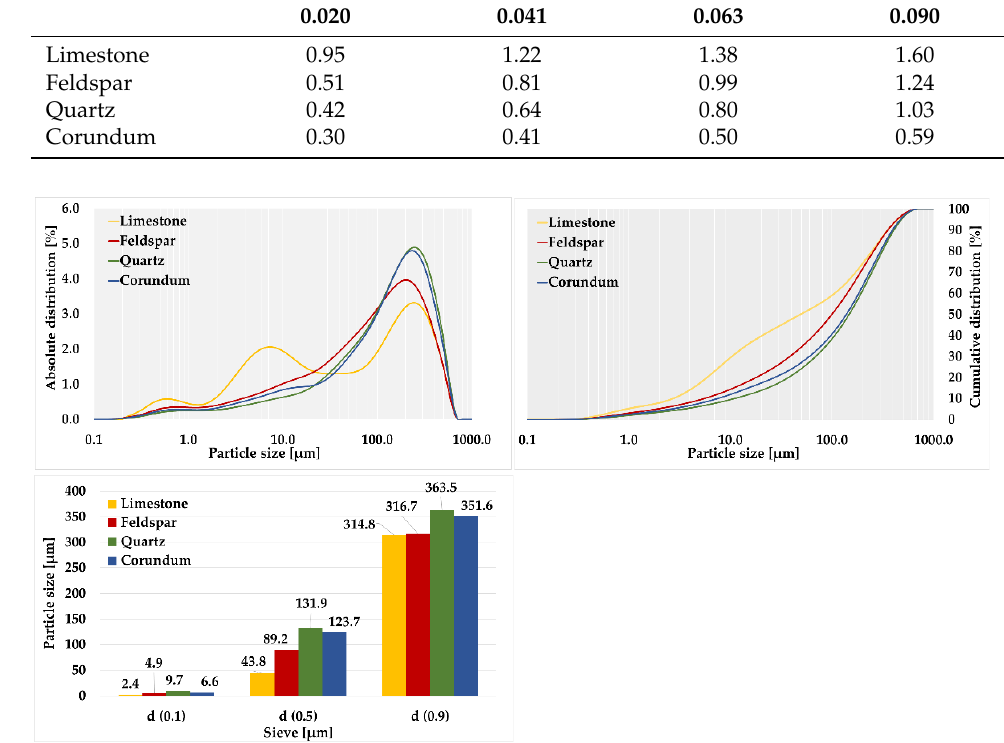
Table 9. Calculated k VTI (SA) (-) indexes according to Equation (9).